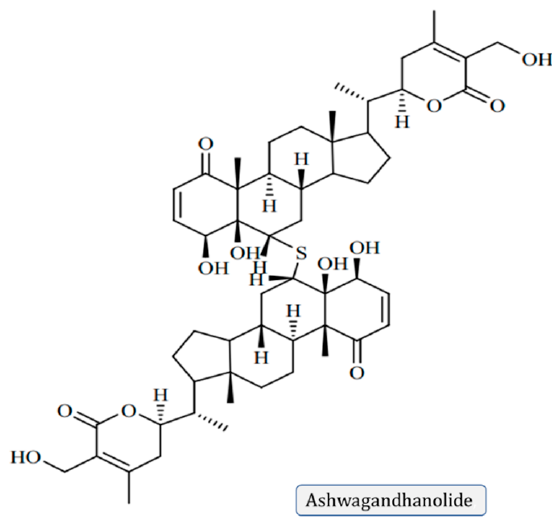
Figure 3. Various chemical structures of different withanolides.